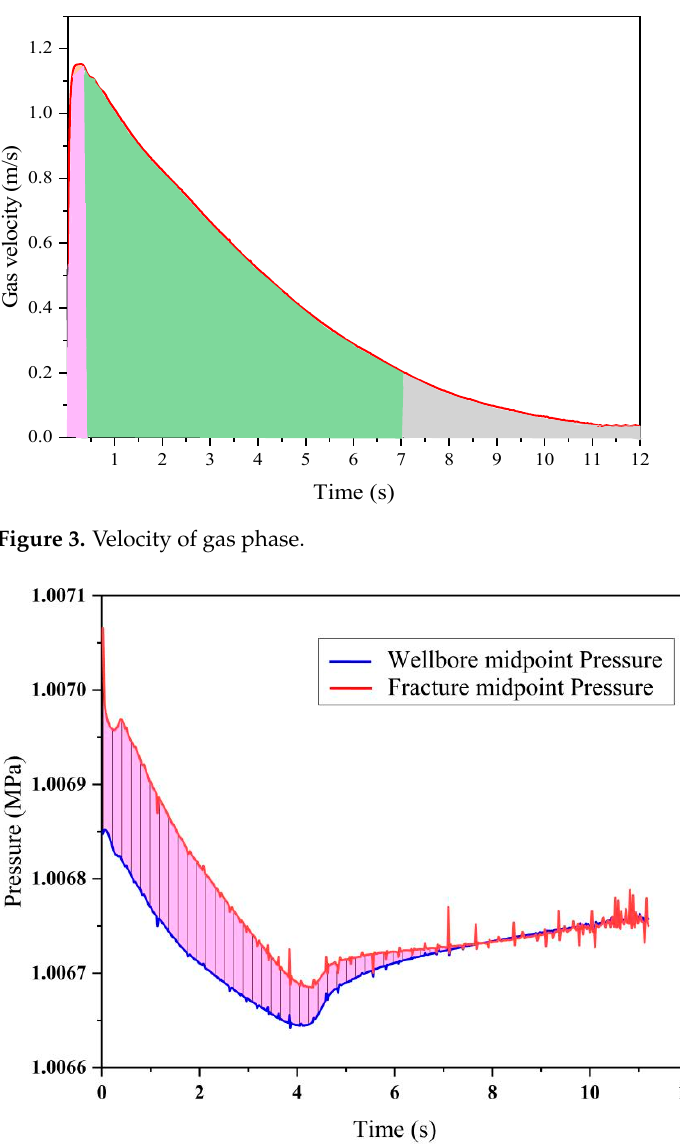
Figure 4. Pressure change of fracture and wellbore